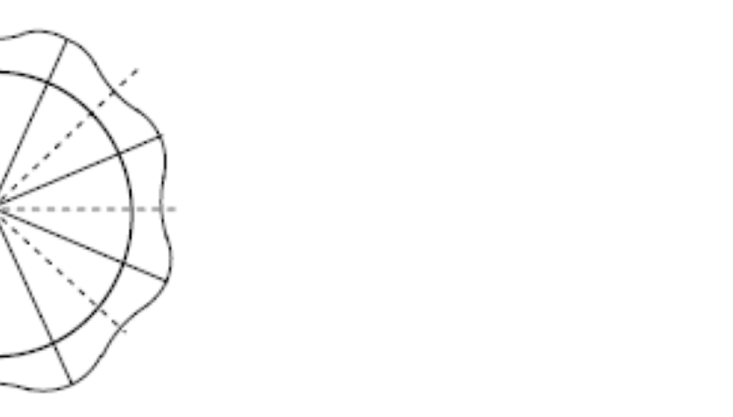
Figure 8. Variation of the thrust along the sections: dotted lines indicate the web centers.